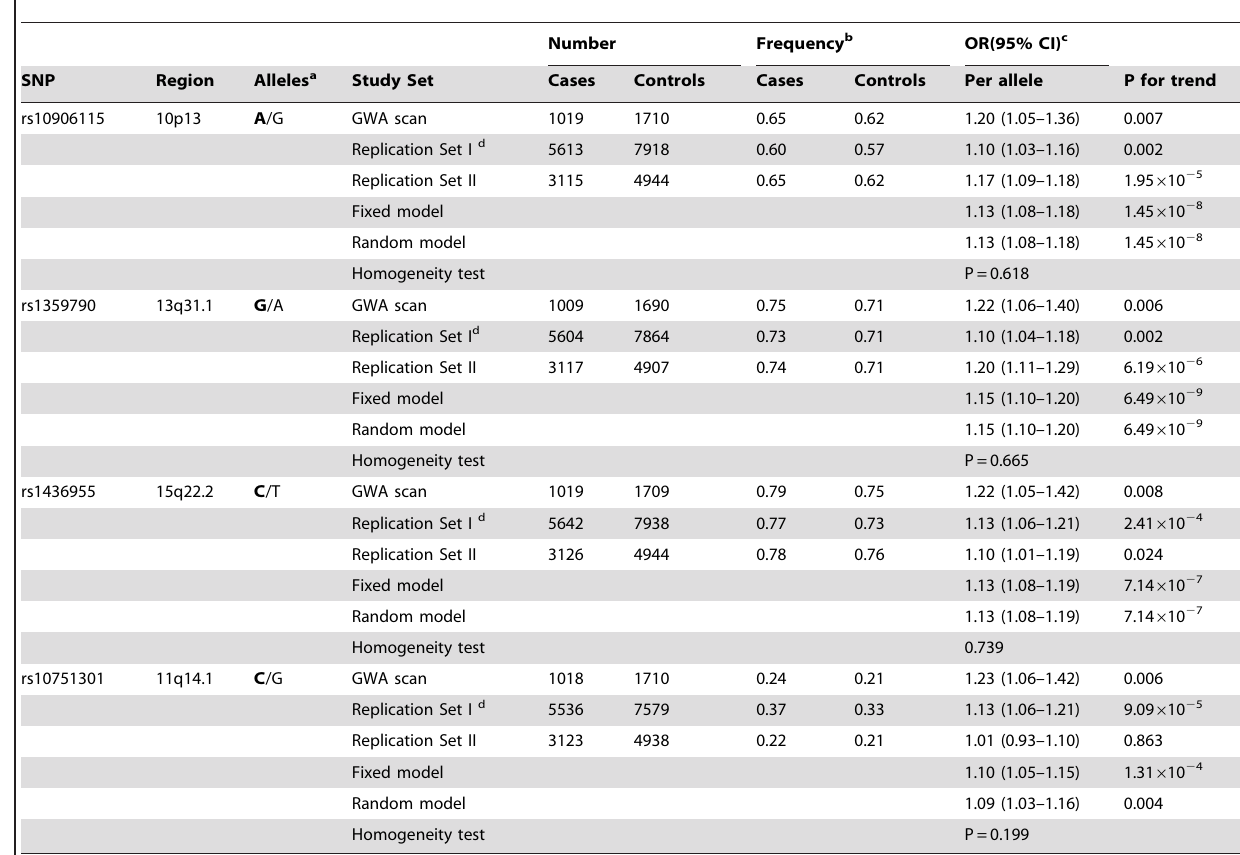
Table 3. Associations of T2D risk with the top four SNPs by study